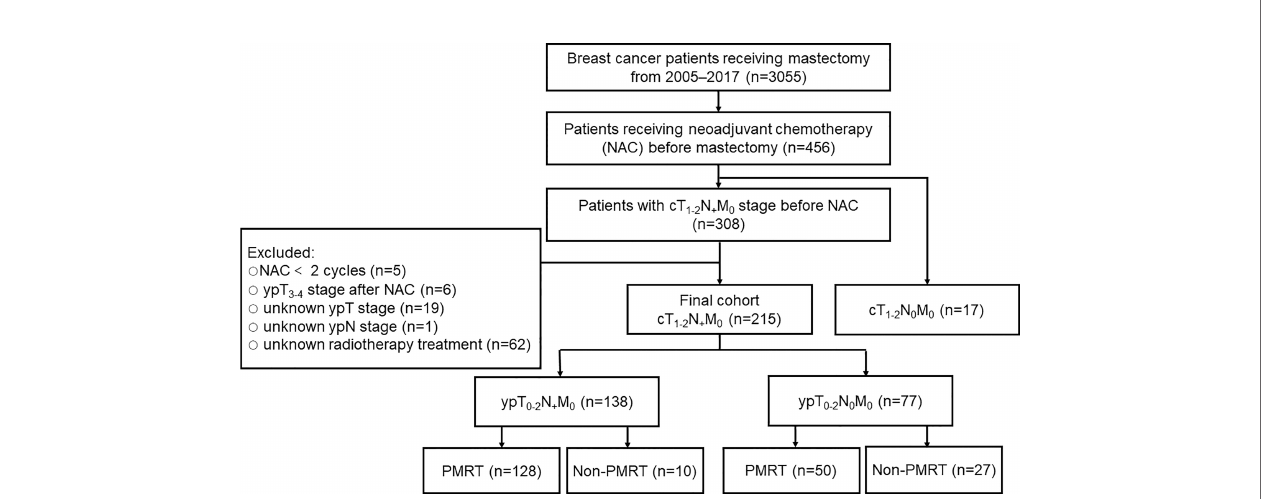
FIGURE 1 | Study design. NAC, neoadjuvant chemotherapy; PMRT, postmastectomy radiotherapy; cT, clinical tumor size; cN, clinical lymph node; ypT, pathologic tumor size after neoadjuvant therapy; ypN, pathologic lymph node after neoadjuvant